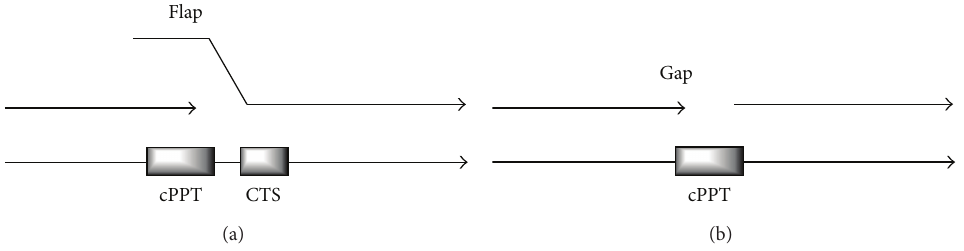
Figure 1: Different reverse transcription outcomes in lenti- (a) and foamy viruses (b). cPPT and CTS abbreviations stand for the central polypurine tract and central termination sequence,